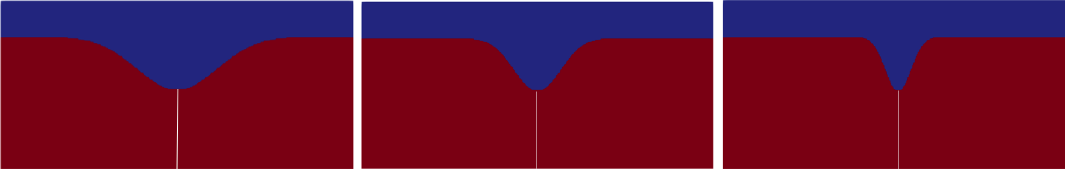
Figure 7. Phase boundaries with different curvature κ 1 = 20 l 1 µ m − 1 , κ 2 = 3 κ 1 and κ 3 = 10 κ 1 . Martensite phase in red, ferrite is in blue and the white line depicts the location where the prior austenite grain boundary (PAGB) would have been if martensite variants of different prior austenite grains were considered.